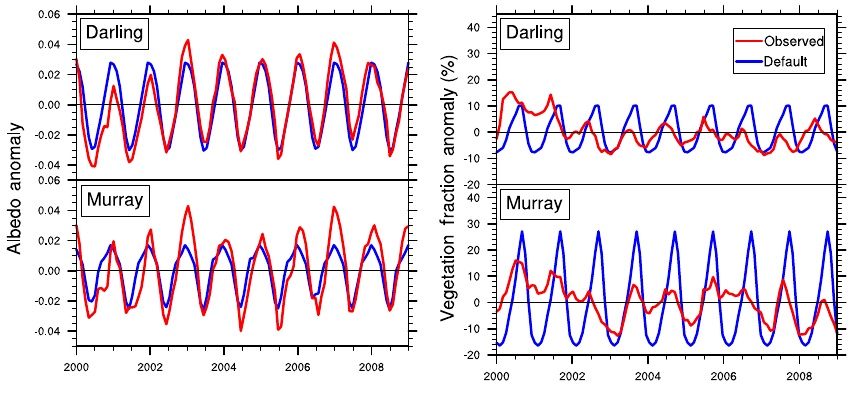
Figure 3. Albedo and vegetation fraction